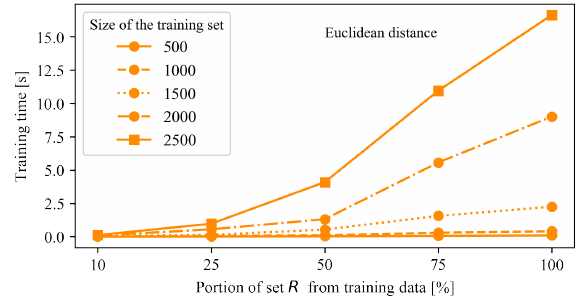
Figure 8. Training time of the MLM using Euclidean distance varying size of the training set and proportion subset R .